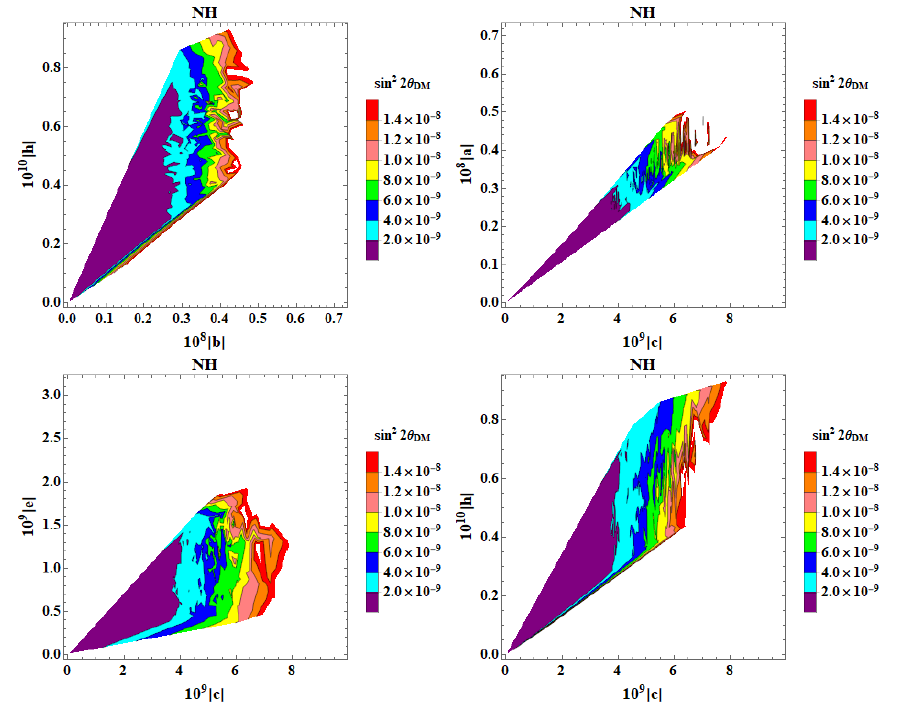
Figure 11 . Variation of di(cid:11)erent model parameters (in eV) with the DM-active mixing as the contour for normal hierarchy. The limit as predicted by cosmology is (10 (cid:0) 12 (cid:0) 10 (cid:0) 8 ).